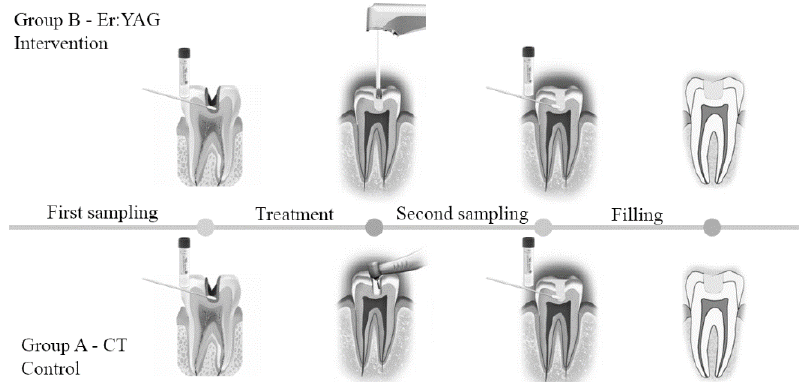
Figure 2. Overview of the sampling and treatment procedures for both groups:( A ) control group; and ( B ) intervention group.